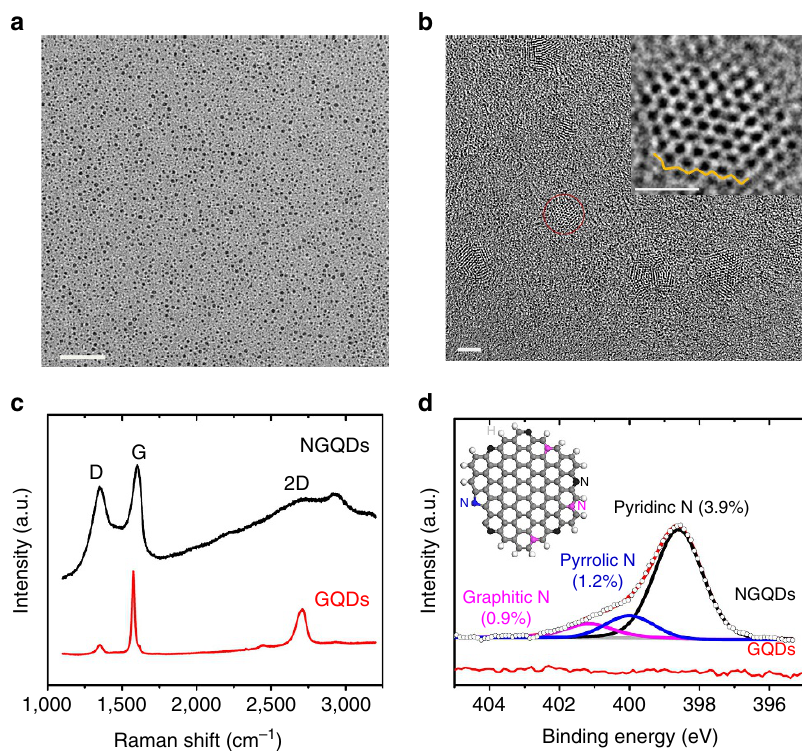
Figure 1 | Nanostructure and specific nitrogen dopant configurations of NGQDs. ( a ) Low-magnification TEM image of NGQDs. Scale bar, 50nm. ( b ) High-magnification TEM image of NGQDs. Scale bar, 2nm. Inset shows a single NGQD containing zigzag edges as circled. The yellow line outlines the zigzag edge. Scale bar in inset, 1nm. ( c ) Raman spectrum of NGQDs as compared with that of pristine GQDs. ( d ) High-resolution N 1 s spectrum for NGQDs, deconvoluted into three sub-peaks representing pyridinic, pyrrolic and graphitic N. The value in parentheses is the corresponding N atomic concentration calculated based on N/(N þ C). The inset is a schematic demonstrating zigzag edges and the N-bonding configuration with respect to pyridinic (black), pyrrolic (blue) and graphitic (pink) N. In comparison, the N 1 s peak does not appear in GQDs